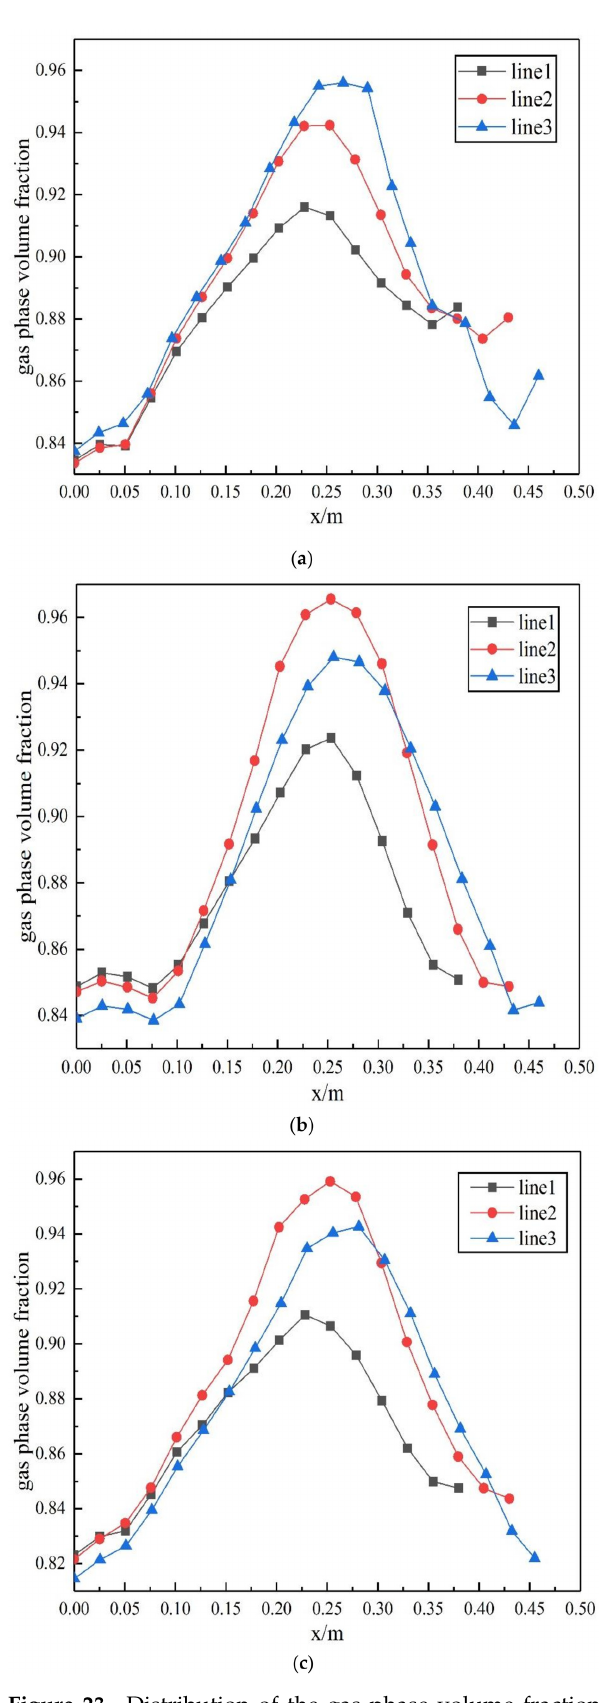
Figure 23. Distribution of the gas phase volume fraction in differentstages: ( a ) initial stage of calculation, ( b ) middle stage of calculation and ( c ) late stage of